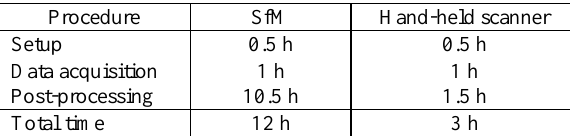
Table 5. Procedure and time required for both